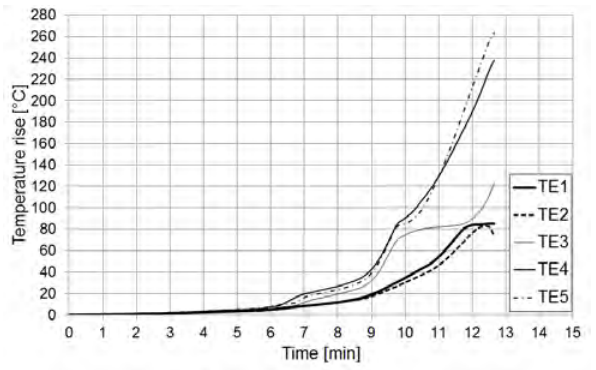
Figure 8: Graph of the temperature rises on unexposed surface of glass unit (thermocouples placed in the quarter of the glass unit and in the glass unit center).